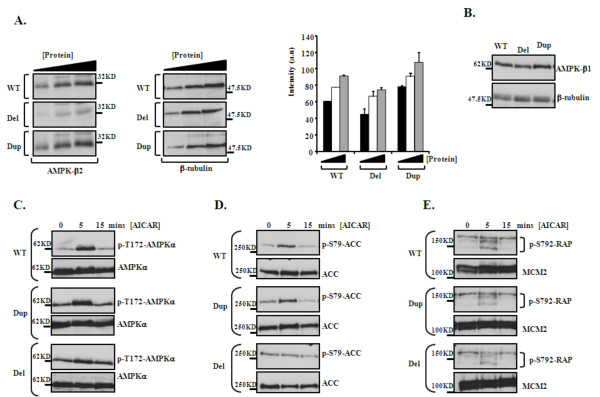
Functional assays for PRKAB2 in patient cells. (A). Left panels:Titrated whole cell extracts wereblotted for AMPKβ2 (encoded by PRKAB2) in wild-type (WT),Del and Dup containing LBCs. Right panels:Blots were re-probed with anti-β-tubulin. Graph: Densiometric quantification of AMPK-β2 expression from titrated extracts, going from low (black bar), intermediate (white) to higher (grey) amounts of protein, normalized to β-tubulin loading, from three separate determinations (a.u. arbitrary units). p = 0.01 for Del and p < 0.005 for Dup LBCs compared to WT. (B). AMPK subunit AMPK-β1, encoded by the PRKAB1 gene on chromosome 12q24.1, shows equivalent expression in the wild-type (WT), Del and Dup containing LBCs. β-tubulin was used to confirm equal loading. (C). AICAR-induced (2 mM) activation of the AMPK kinase was monitored using phosphorylation of the AMPKα subunit on threonine 172 (p-T172-AMPKα). Dup and Del containing LBCs exhibited higher levels of p-T172-AMPKα at the 0 time (untreated), relative to wild-type (WT). Only the 1q21.1 Del containing LBCs appeared to be unresponsive to AICAR-treatment here. Blots were re-probed with for native AMPKα to confirm loading. (D). AICAR-induced (2 mM) activation of AMPK was evaluated by monitoring phosphorylation of the AMPK substrate Acetyl-CoA Carboxylase on serine 79 (p-S79-ACC). Similar to p-T172-AMPKα, the Del containing LBCs appear unresponsive to the AICAR treatment. Blots re-probed for native ACC to confirm loading. (E). AICAR-induced activation of AMPK was also evaluated by phosphorylation of the AMPK substrate RAPTOR on serine 792 (p-S792-RAP) under identical conditions as in (B) and (C). Again, Del containing LBCs appeared somewhat unresponsive to AICAR. Blots re-probed for MCM2 to confirm loading.